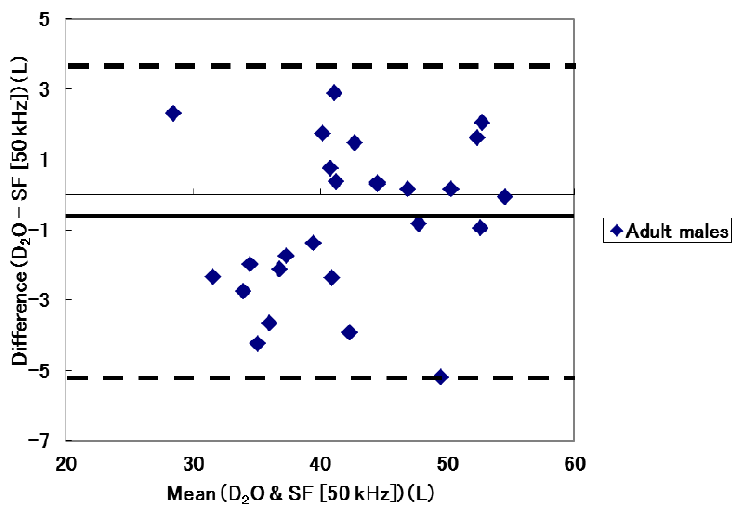
Figure 2. Bland and Altman plots between TBW estimated from the dilution technique and single-frequency mode (50 kHz) for ( a ) adult males and ( b )